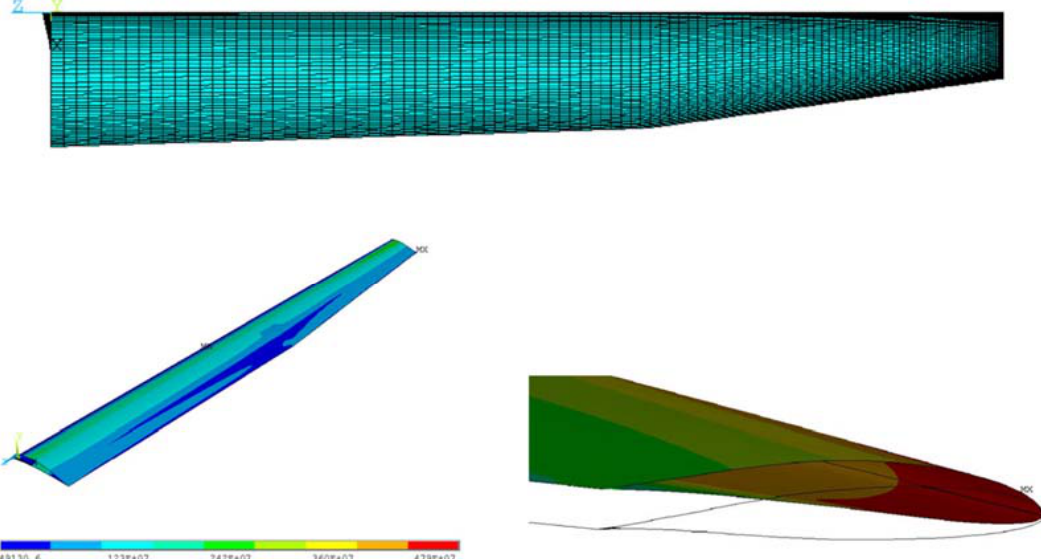
Figure 3. Planform detail of the FEM (up); actuation stress intensity in design conditions (down left) and detail of the tip airfoil twist compared to the unactuated position (down right) (reproduced from [26]).